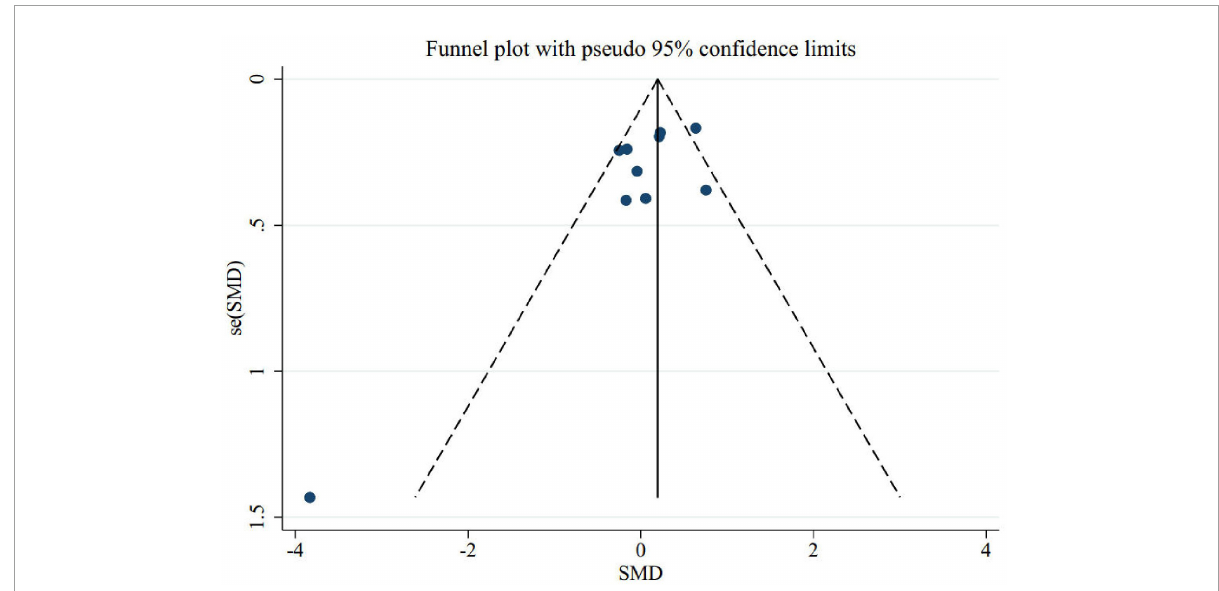
FIGURE4 Funnel plot for the effect of folic acid supplementation on memory to identify publication